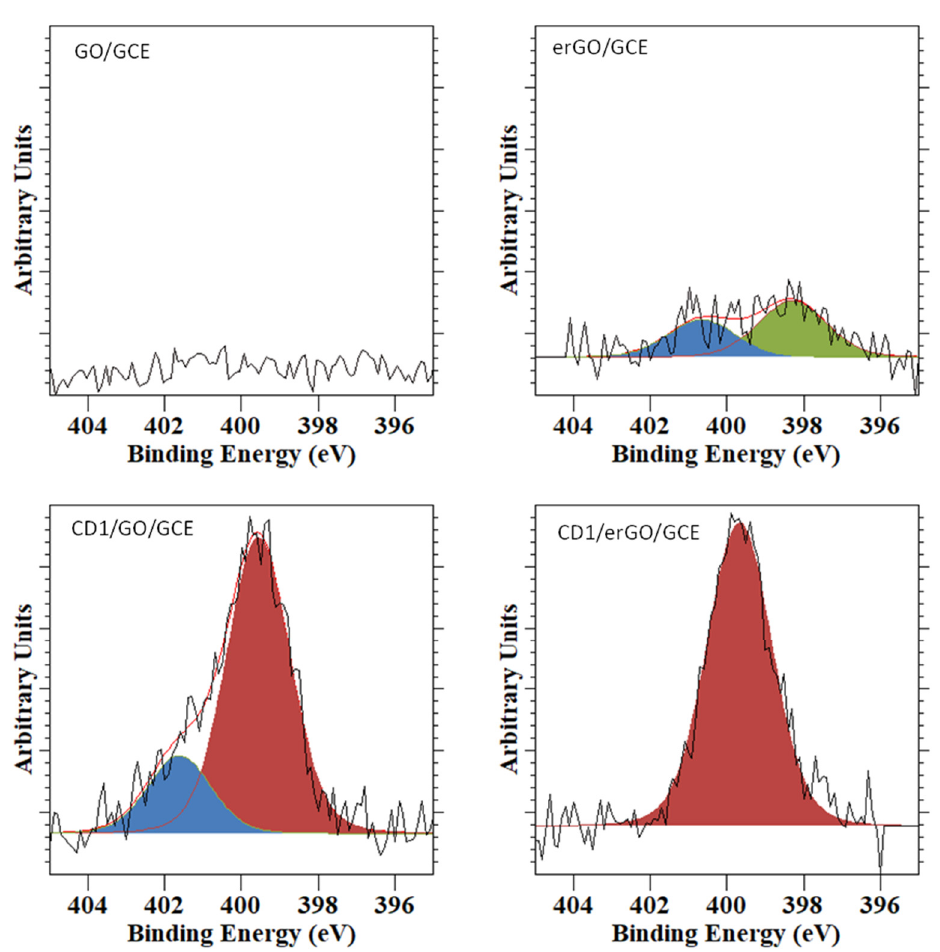
Figure 5. N 1s XPS spectra recorded from the di ff erent samples.